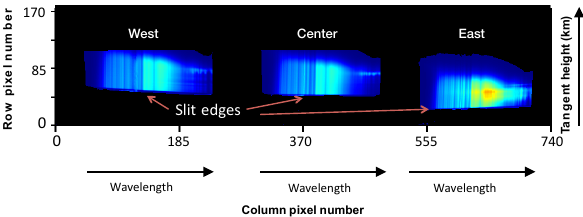
Figure 6. OMPS LP CCD high-gain Earth-viewing radiance images for the three slits (east/center/west). The east and west slit images are separated in longitude by 2.25 ◦ from that of the center slit. The wavelength range for each image is 270 to 1050nm, and the mini- mal TH range is 0 to 80km. The CCD has 740 pixels in the wave- length dimension. There are 340 pixels in the spatial dimension; the high-gain images occupy the lower half of the CCD (pixels 0 to 170). The spatial extent of each slit’s image on the detector is limited by the vertical length of that slit. The lower slit edges (near- est the Earth surface) provide a high-contrast signal cutoff that can be monitored for movement.